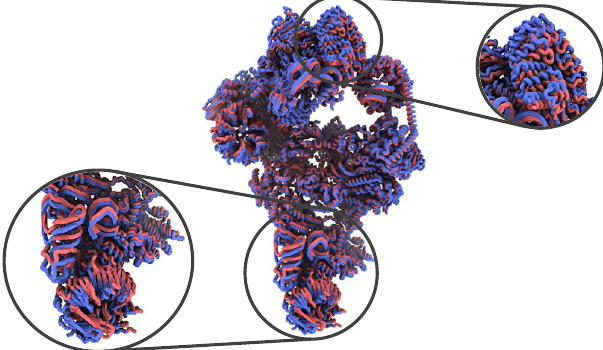
Fig. 5 | Example of recovered Zernike3D spliceosome states at atomic level. Example of two conformations obtained from the KMeans clustering of the Zer- nike3D space in Fig. 4. The conformations were obtained after applying the Zer- nike3D deformation fi elds to the atomic structure associated with the reference map used during the Zernike3D analysis. The versatility of the Zernike3D results allows following both, the local and global conformational changes due to the atom ’ s motion, as shown from the different zooms in the recovered